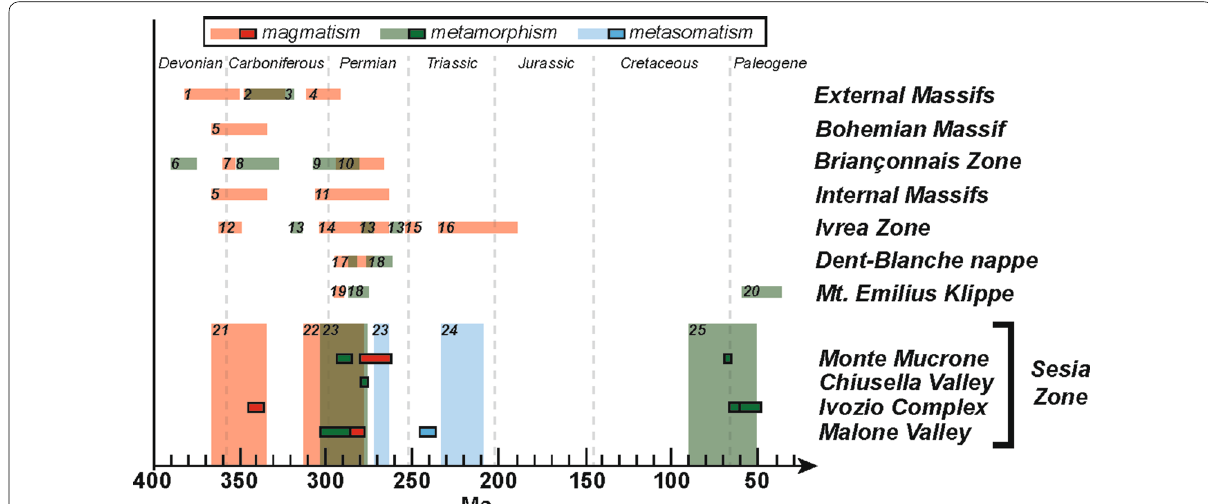
Fig. 11 Summary of the magmatic and metamorphic ages in the SZ compared with literature data from relevant units of the Western Alps, the Ivrea Zone and various portions of the Variscan chain. Filled boxes represent age data from this study; semi-transparent boxes represent literature ages: (1) Ménot et al. (1988); (2) Schaltegger and Corfu (1992), Bussy et al. (2000), Guerrot and Debon (2000), Rubatto et al. (2001), Musumeci and Colombo (2002), Oliot et al. (2015); (3) Bussy et al. (2000); Rubatto et al. (2001, 2010); (4) Schaltegger and Corfu (1992), Schaltegger (1993), Bussy and von Raumer (1994), Schaltegger and Corfu (1995), Bussy et al. (2000), Capuzzo and Bussy (2000), Guerrot and Debon (2000), Bussien Grosjean et al. (2017); (5) Pin et al. (1988); (6) Giacomini et al (2007); (7) Bertrand et al. (2000), Guillot et al. (2012); (8) Monié (1990), Bussy et al. (1996); (9) Giorgis et al. (1999); (10) Bussy et al. (1996), Scheiber et al. (2014); (11) Bussy and Cadoppi (1996), Paquette et al. (1999), Bertrand et al. (2000), Liati et al. (2001), Pawlig (2001), Bertrand et al. (2005), Ring et al. (2005); (12) Vavra et al. (1996); (13) Ewing et al. (2013); (14) Pin (1986), Voshage et al. (1987), Mayer et al. (2000), Garuti et al. (2001), Vavra and Schaltegger (1999), Peressini et al. (2007), Karakas et al. (2019); (15) Wright and Shervais (1980); (16) Stähle et al. (1990), Lu et al. (1997), Oppizzi and Schaltegger (1999), Schaltegger et al. (2008; 2011), Zanetti et al. (2013); (17) Bussy et al. (1998), Manzotti et al. (2018), Monjoie et al. (2007); (18) Kunz et al. (2018); (19) Bussy et al. (1998); (20) Burn (2016); (21) Rubatto (1998), Rubatto et al. (1999); (22) Bussy et al. (1998); Cenki-Tok et al. (2011); Paquette et al. (1989); Rubatto (1998) and Rubatto et al. (1999); (23) Kunz et al. (2018); (24) Rubatto (1998); (25) Babist et al. (2006); Cenki-Tok et al. (2011); Dal Piaz et al. (2001); Duchêne et al. (1997); Giuntoli et al. (2018a); Halama et al. (2014); Inger et al.